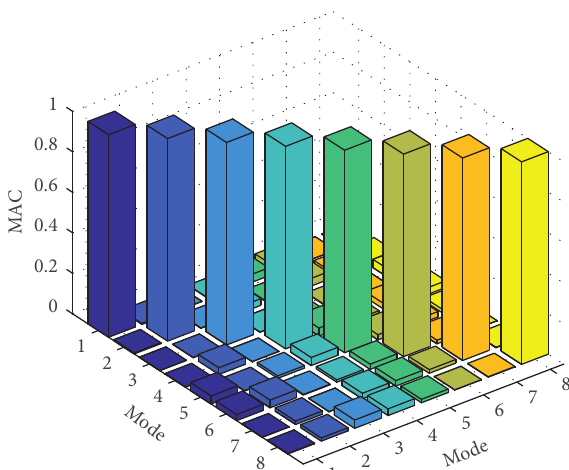
Figure 10: 15-sensor iteration curve.